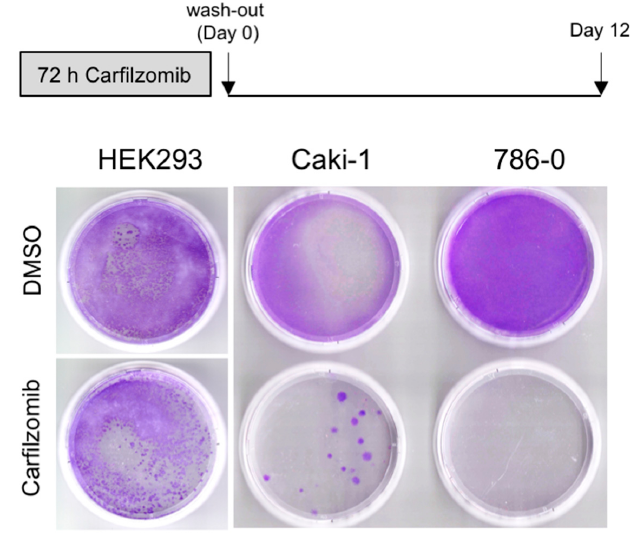
Figure 4. Long-term antitumoral effects of carfilzomib are cell type-dependent. Colony growth assay comparing non-cancerous HEK293 cells to Caki-1 ( VHL wildtype) and 786-0 ( VHL -deficient) RCC cell lines over 12 days. Note the absence of colonies in 786-0 cells.